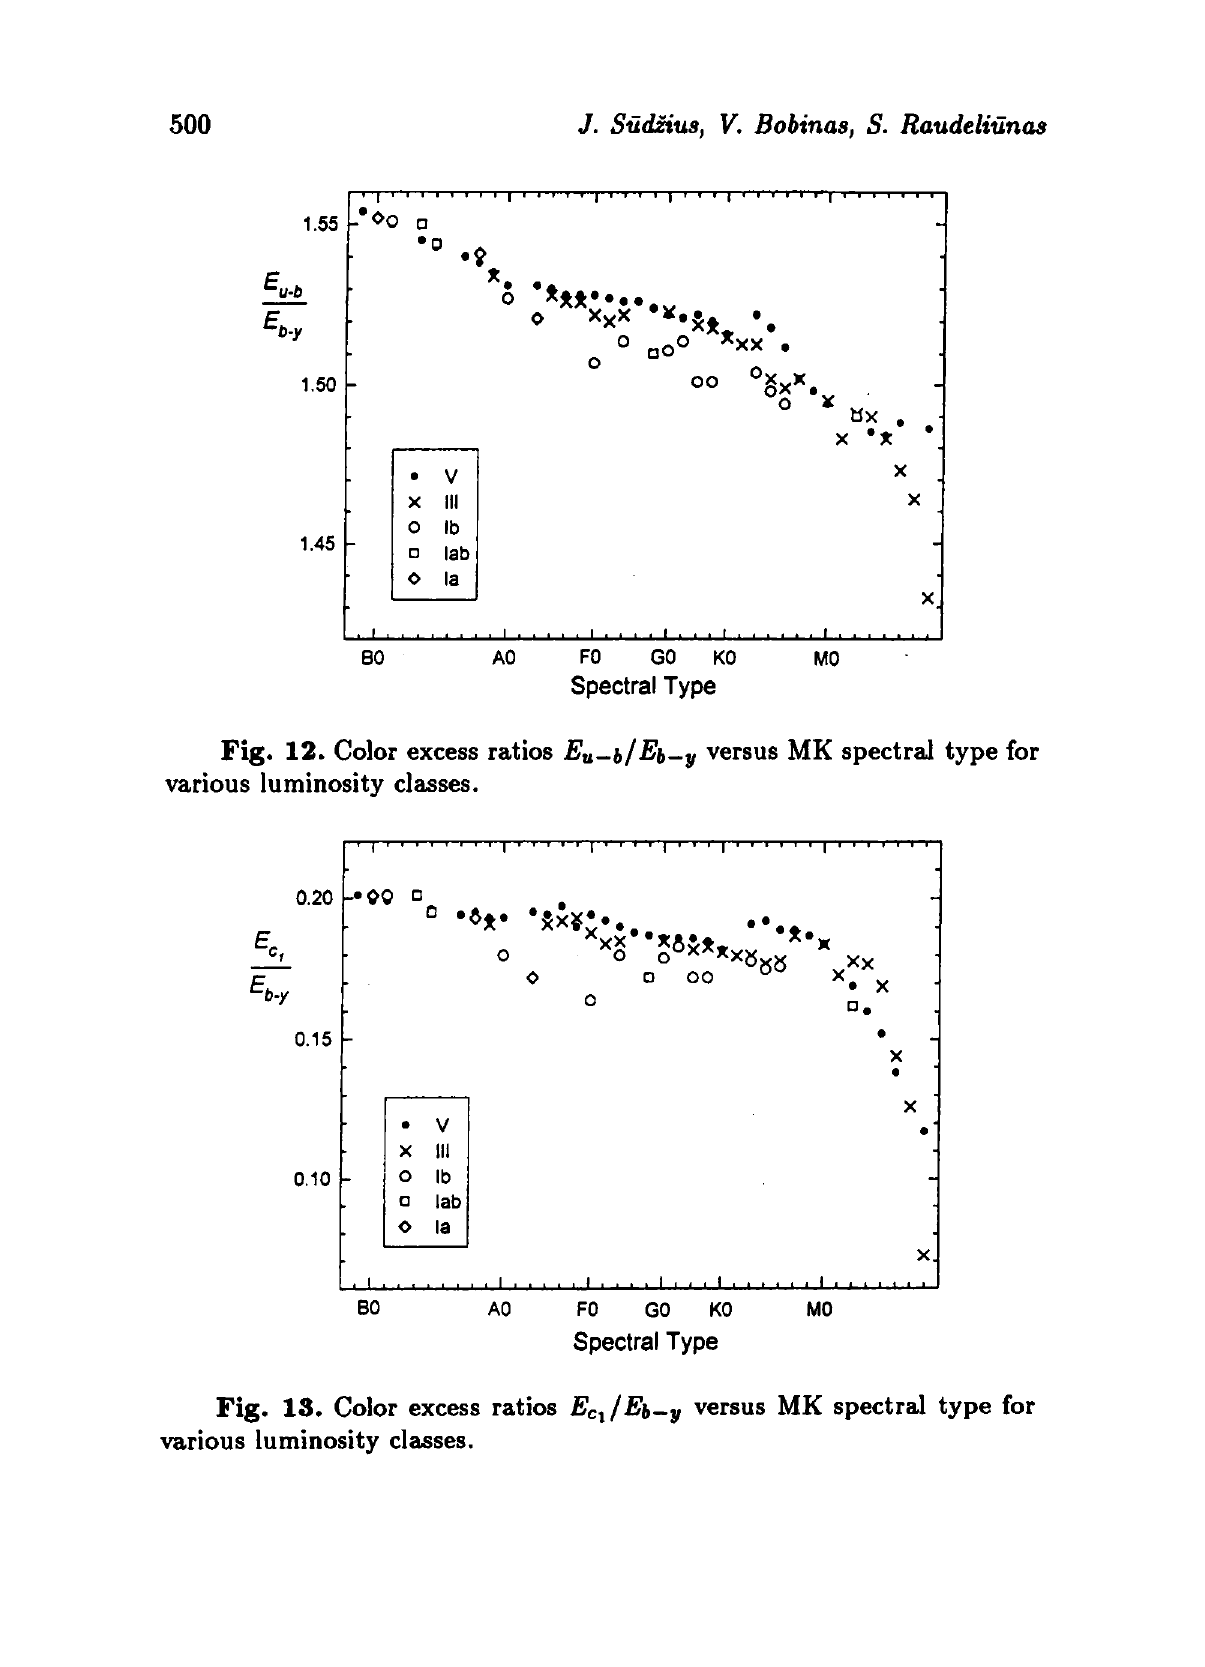
Fig. 13. Color excess ratios E various luminosity